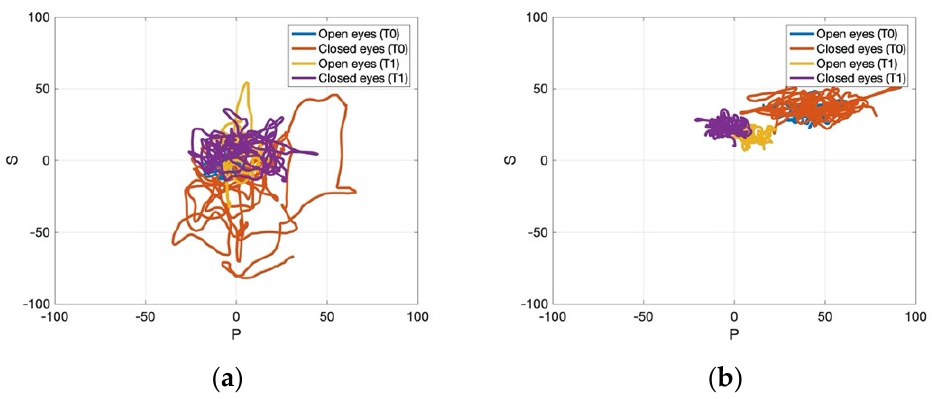
Figure 4. Static stabilometric assessment with eyes open and eyes closed for one representative patient in the control group ( a ) and experimental group ( b ) pre- and post-treatment. Abbreviations: T0: pre-treatment; T1: post-treatment.